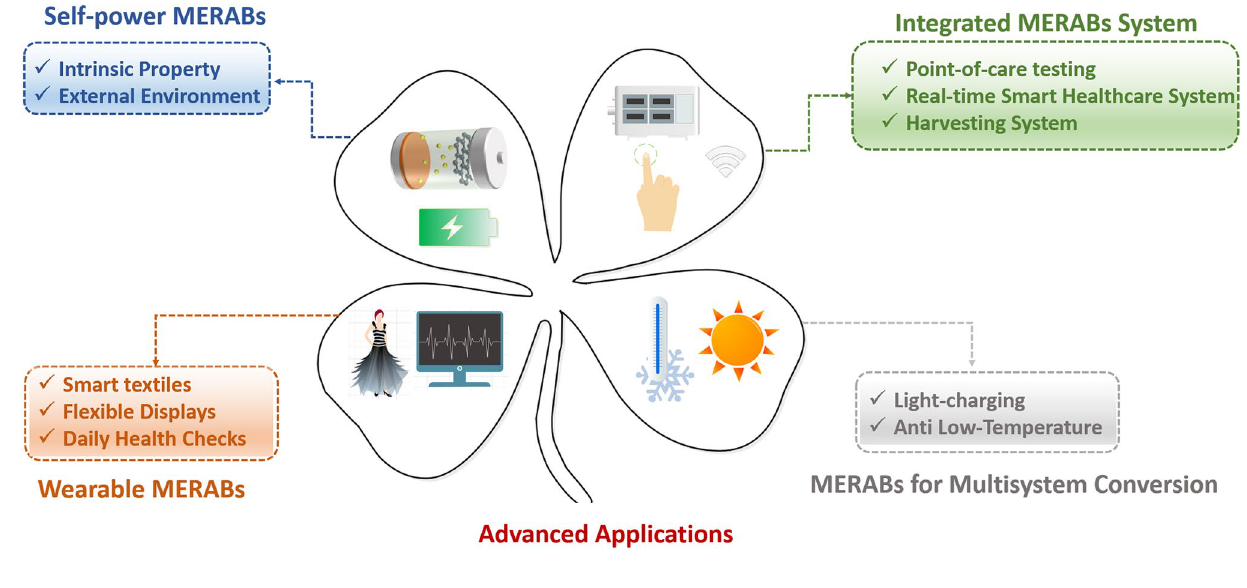
Fig. 15 Summary of recent advances in MERABs